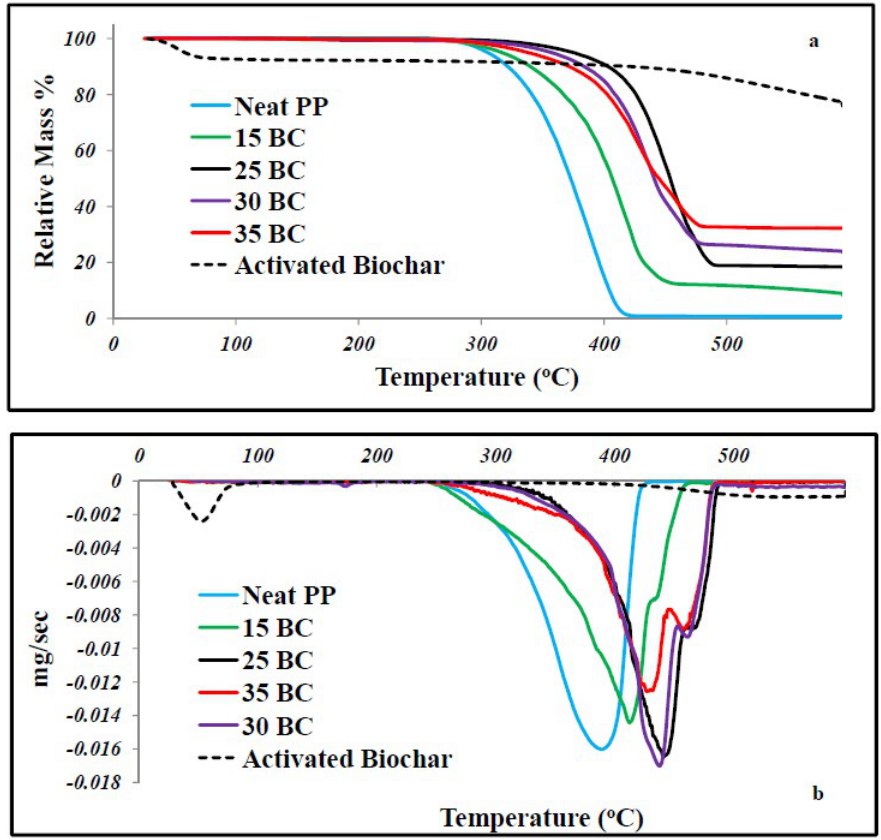
Figure 6. The TGA and DTG curves of biochar filled polypropylene composites, ( a ) TGA (mass loss) curve and ( b ) DTG curve. A significant shift in the degradation temperature of the composite in comparison to neat polymer can be observed. The image is modified from [5] with permission from Elsevier publications 2016 for reusing and modifying the